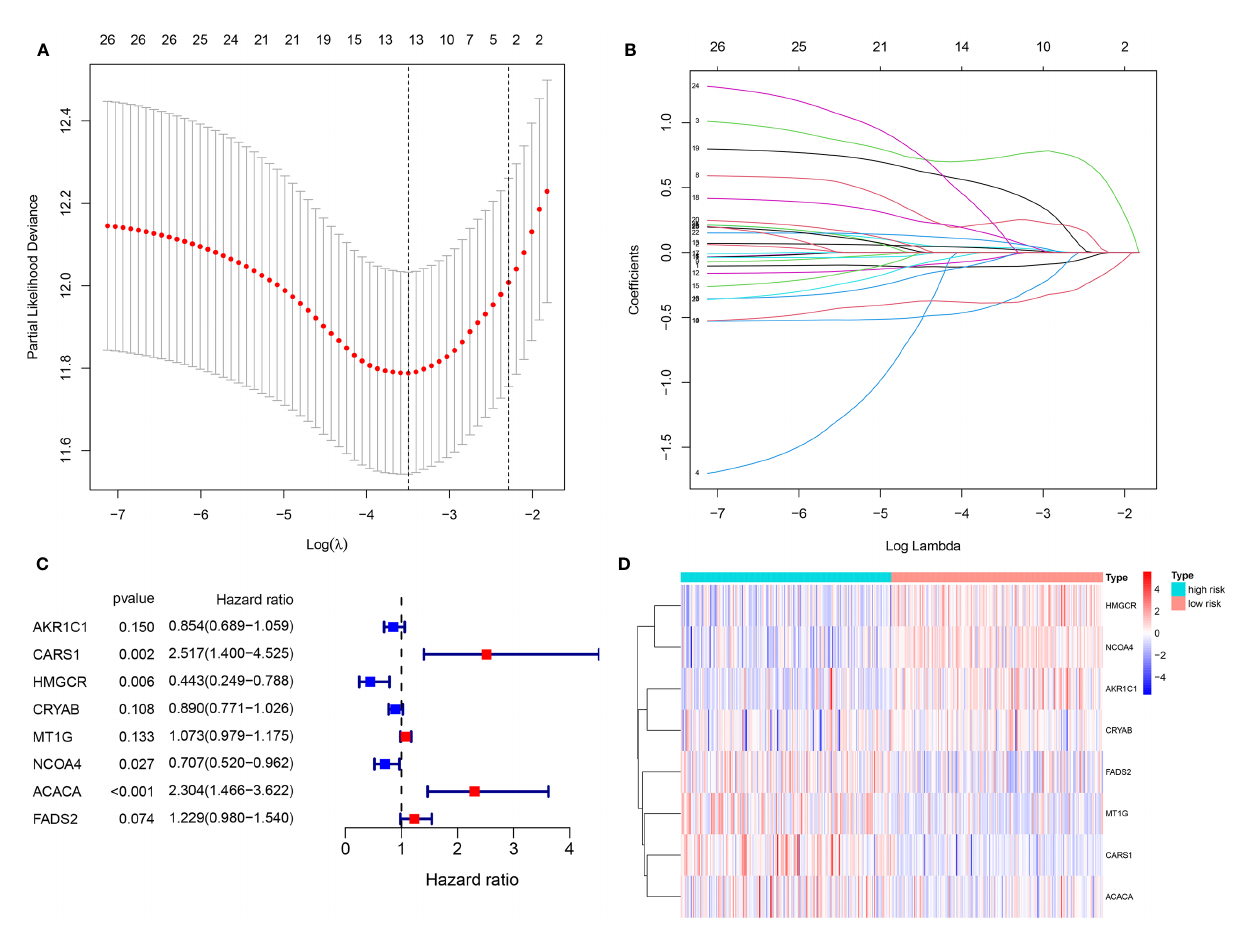
FIGURE 4 | Identi fi cation of eight optimal FRGs. (A, B) LASSO regression analyses of 26 PDEFRGs. (C) Forest plots showing eight selected optimal risk FRGs. (D) The heat map of eight optimal